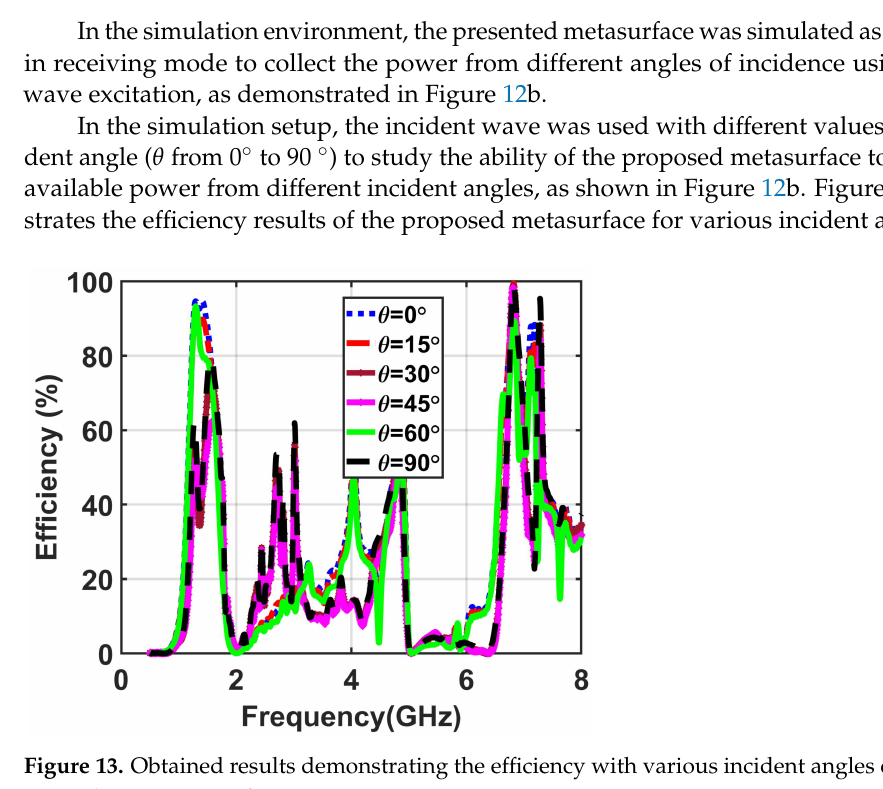
Figure 12. ( a ) Geometry of the implemented 8 × 8 metasurface, ( b ) available power from different incident angles.